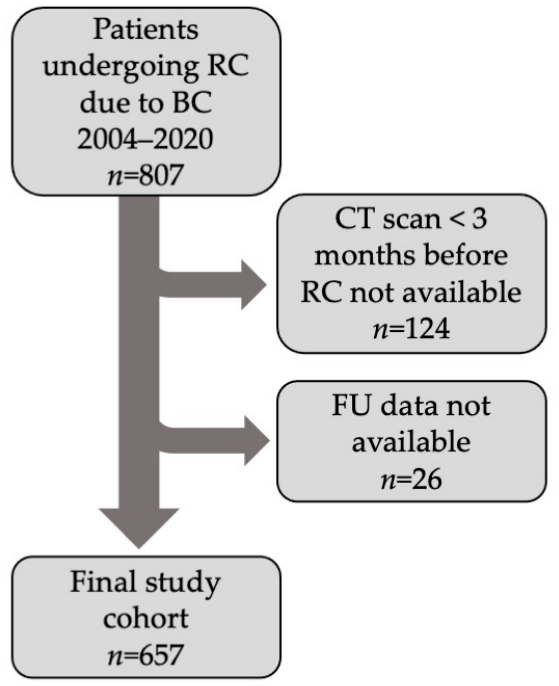
Figure 1. Flowchart showing patient inclusion criteria and final study cohort.